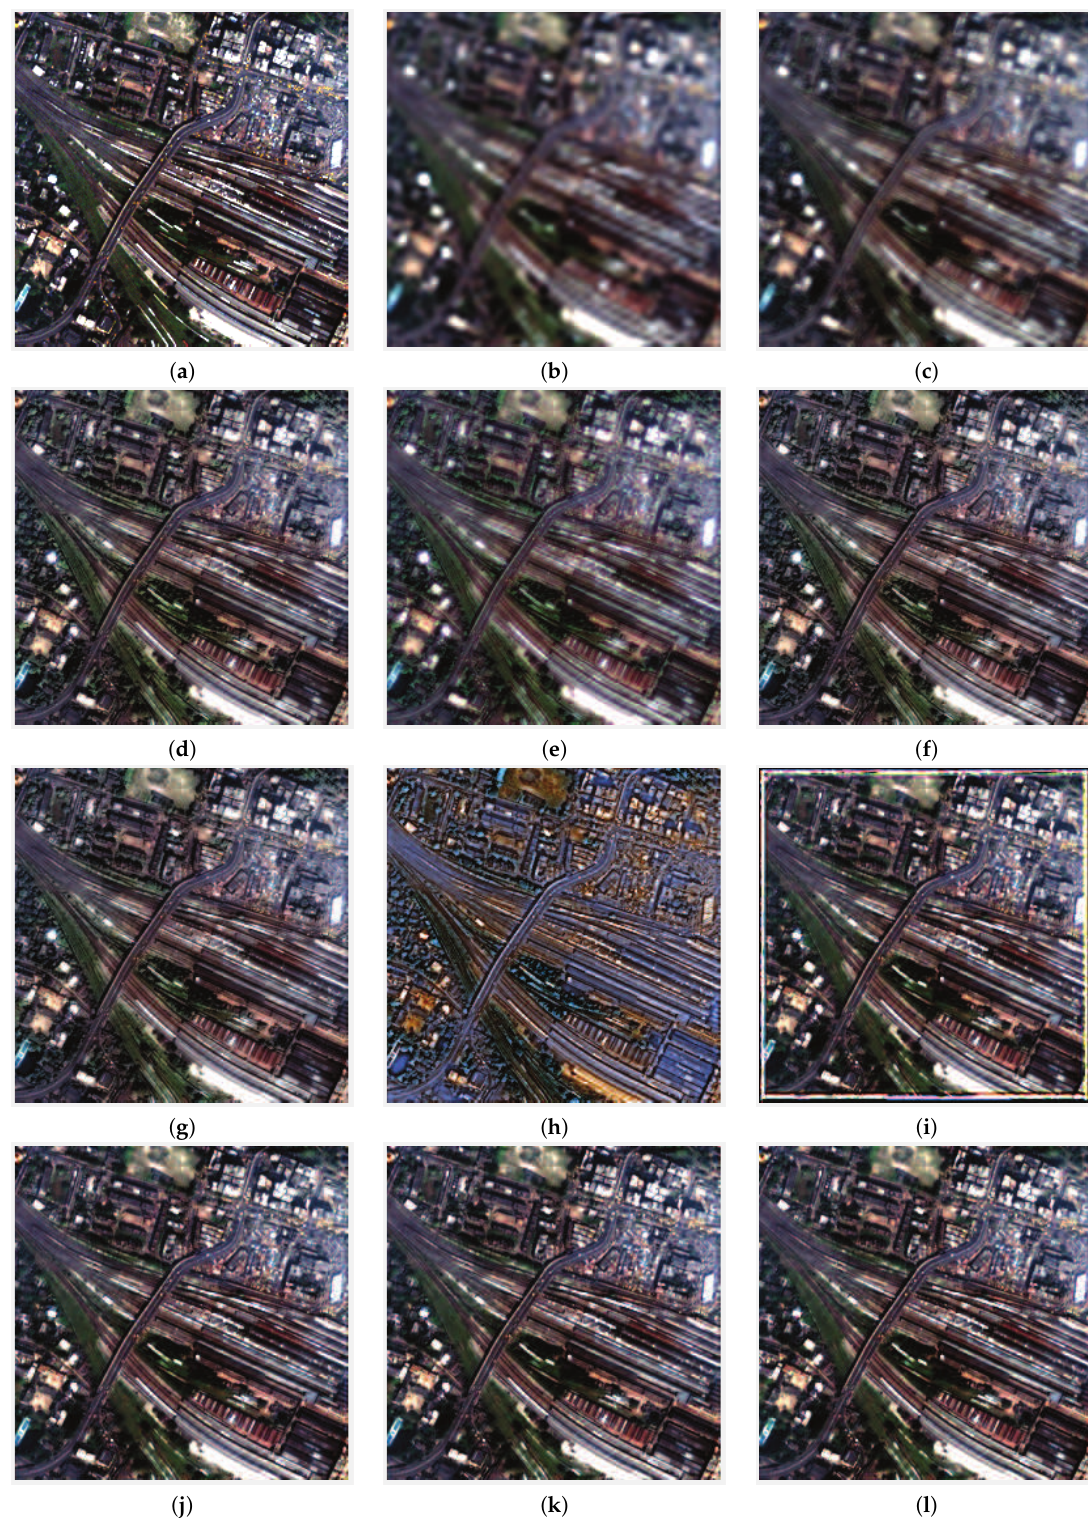
Figure 6. Pansharpening results for the Quickbird dataset: ( a ) ground truth; ( b ) EXP; ( c ) PCA; ( d ) GSA; ( e ) PRACS; ( f ) ATWT; ( g ) MTF-GLP-HPM; ( h ) CNMF; ( i ) PNN; ( j ) DRPNN; ( k ) DiCNN1; and ( l )